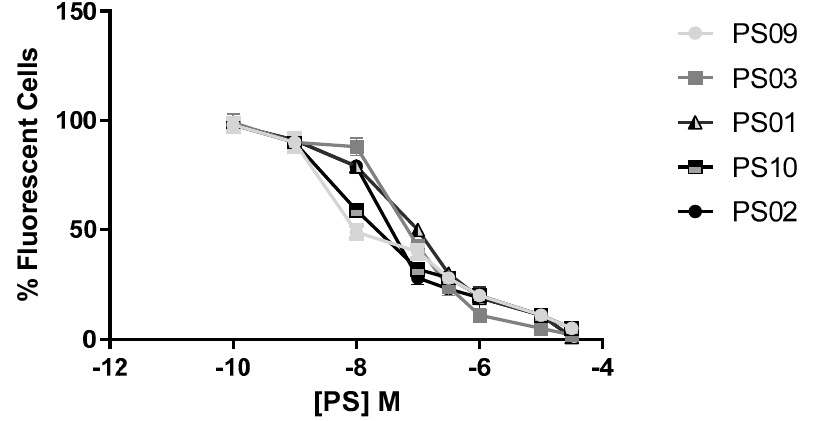
Figure 4. Dose − response curve for the sulfonamides. Peritoneal macrophages were pretreated for 10 min with sulfonamides at crescent concentrations and subsequently stimulated with 5 mM ATP for 15 min. As an inhibition control, the cells were treated with A740003 at 10 µ M for 10 min (data not shown). The error bar is representative of 3 experiments in triplicate on 3 different days. M – drug concentration.